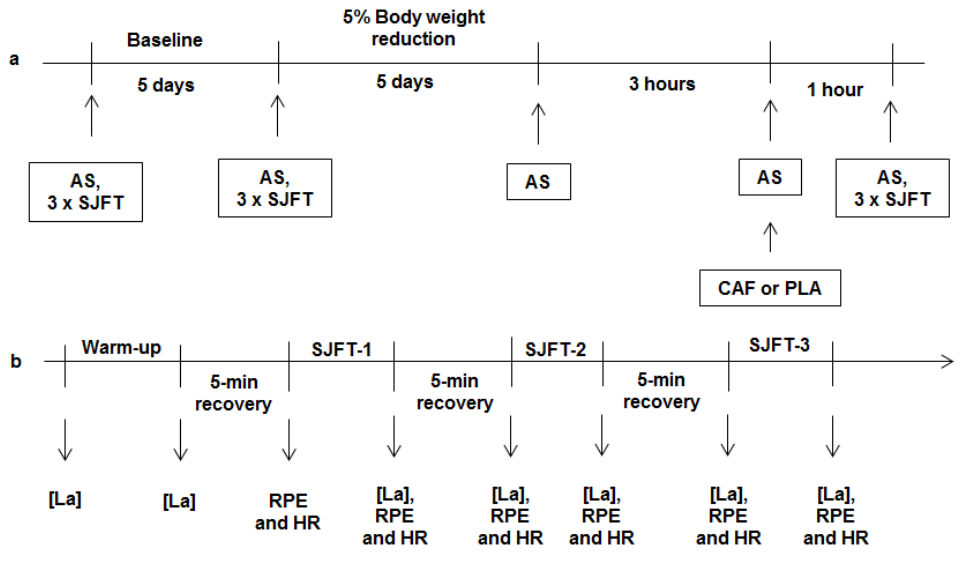
Figure 1. ( a ) Experimental design. ( b ) Performance protocol. AS: Anthropometric assessment; SJFT: Special judo fitness test; CAF: caffeine; PLA: placebo; [La]: plasma lactate concentration; RPE: rating of perceived exertion; HR: heart